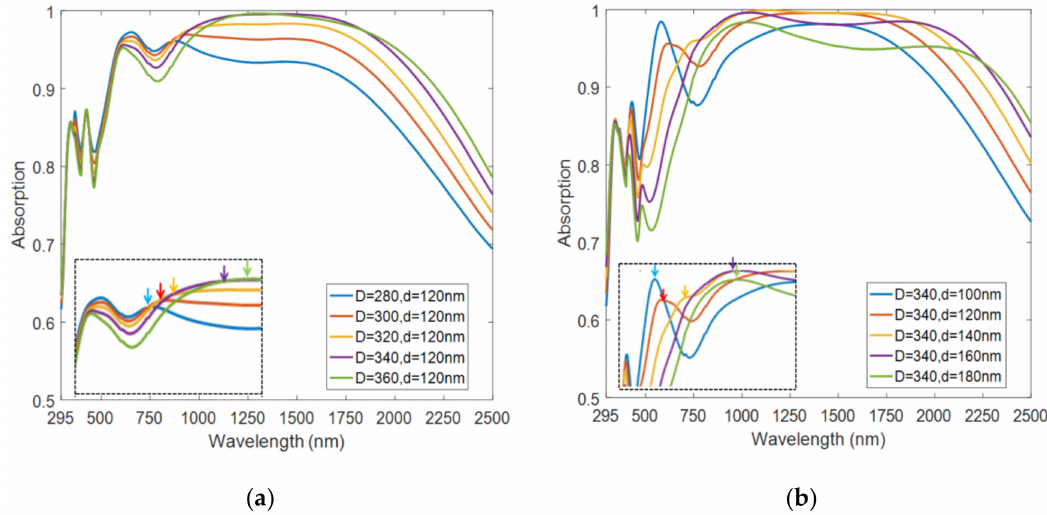
Figure 6. Normalized absorption spectra under different parameters. ( a ) Absorption spectrum of a constant short-axis length of the elliptical nanodisk with an increased length of the long axis. ( b ) Absorption spectra of a constant long-axis length of the elliptical nanodisk with an increased length of the short axis.